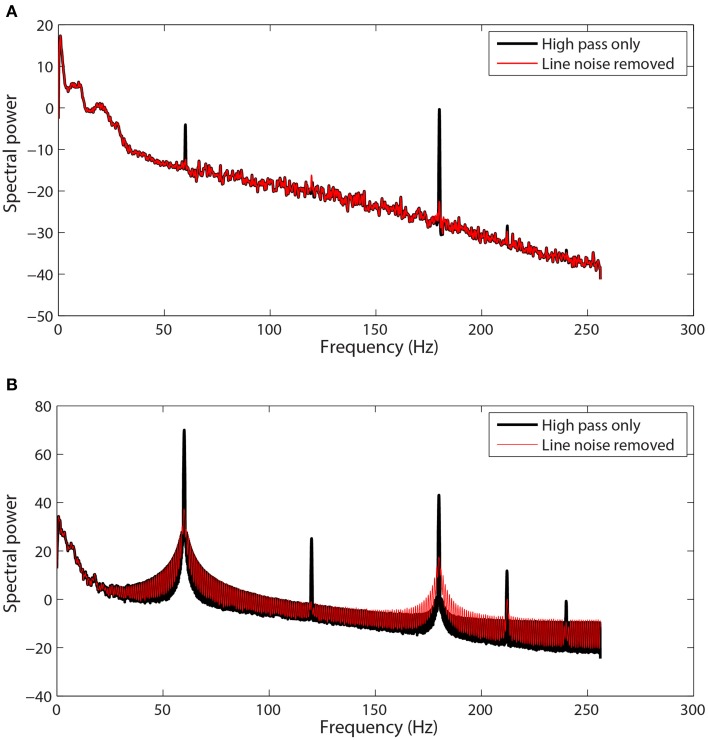
Selected channel spectra from 64-channel Biosemi EEG before and after line noise removal. Spectral power is in units of 10log10(μV2). Data was high-pass filtered at 1 Hz prior to line noise removal. (A) A channel with sharp peaks at 60 and 180 Hz. (B) A channel contaminated by non-stationary transformer noise. This channel is interpolated at a later stage in the pipeline.